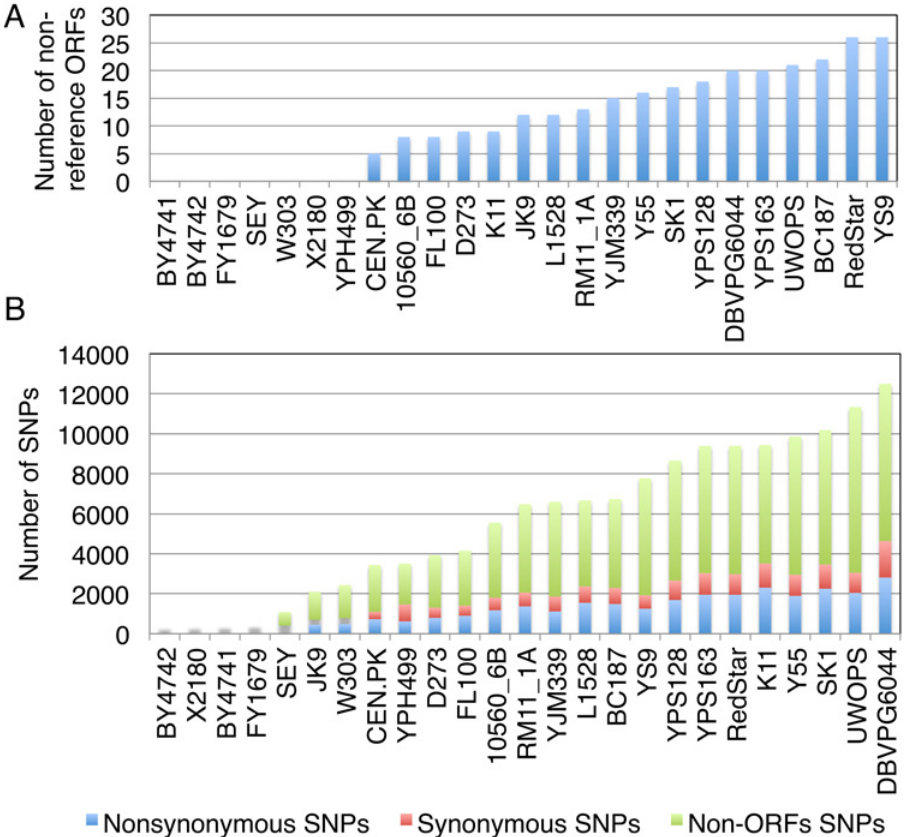
Fig 3. Variations in S . cerevisiae strains. (A) Number of non-reference ORFs in 25 S . cerevisiae strains. (B) Number of SNPs relative to the reference. According the number of SNPs, BY4742, X2180, BY4741, and FY1679 are essentially identical to the reference strain (S288C) and there are no non-reference ORFs in these strains. This supports the notion that these four strains are the same as S288C within experimental error. The variation patterns between non-reference ORFs and the number of SNPs show that strains that have more SNPs tend to have more non-reference ORFs, but there are some strains that have different patterns (e.g. K11 and